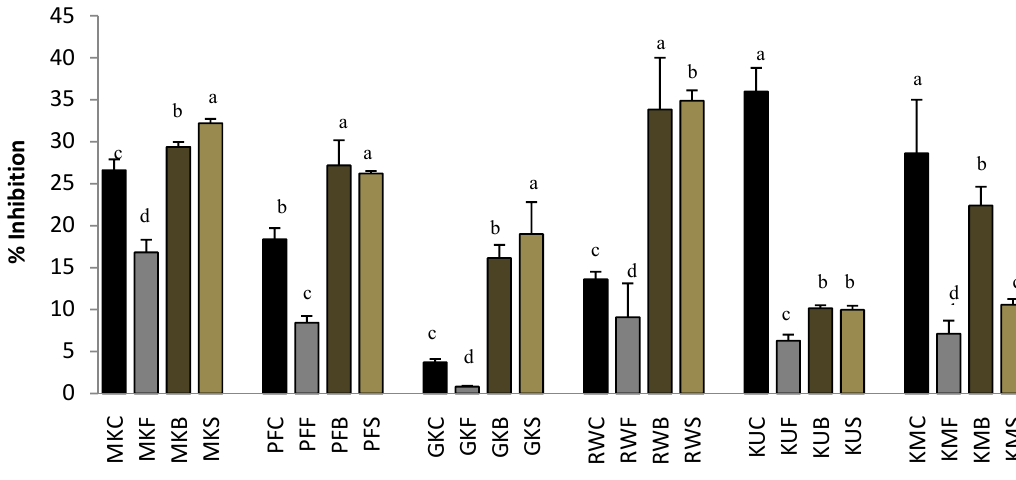
Figure 3. Lipoxygenase inhibition ability of raw and cooked extracts of some GLV. Values represent means of triplicate readings. MK, O. zeylanica ; RW, C. auriculata ; KM, S. grandiflora ; KU, G. lactiferum ; PF, P. edulis ; GK, C. asiatica . C-fresh leaves; F-fried; B-boiled; S-steamed. Data are presented as means ± standard deviations of three replicate determinations. Columns with different letters for each vegetable are significantly different ( p < 0.05).